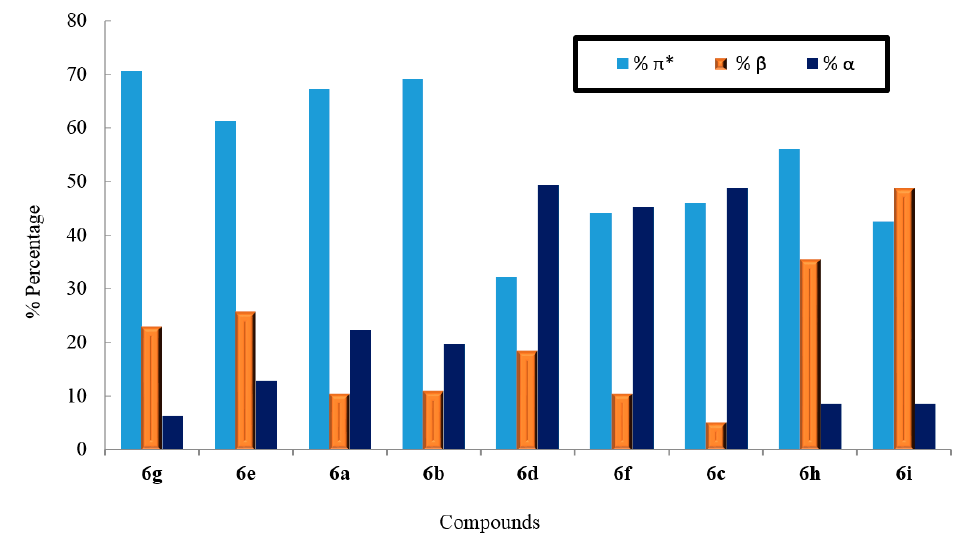
Figure 5. Percentage contribution of the solvatochromic parameters: π *, β and α .